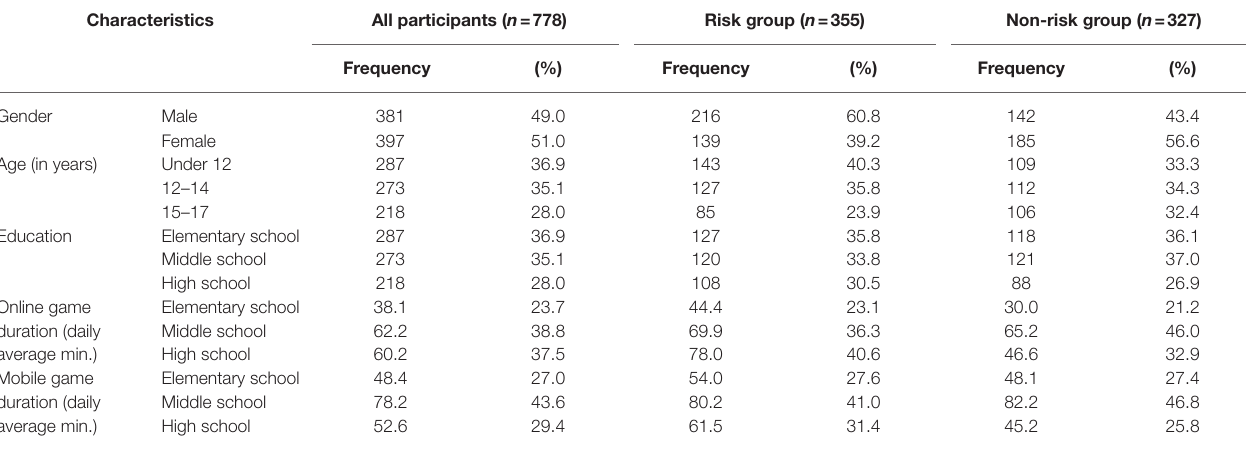
TABLE 2 | Demographic characteristics. Characteristics All participants ( n =